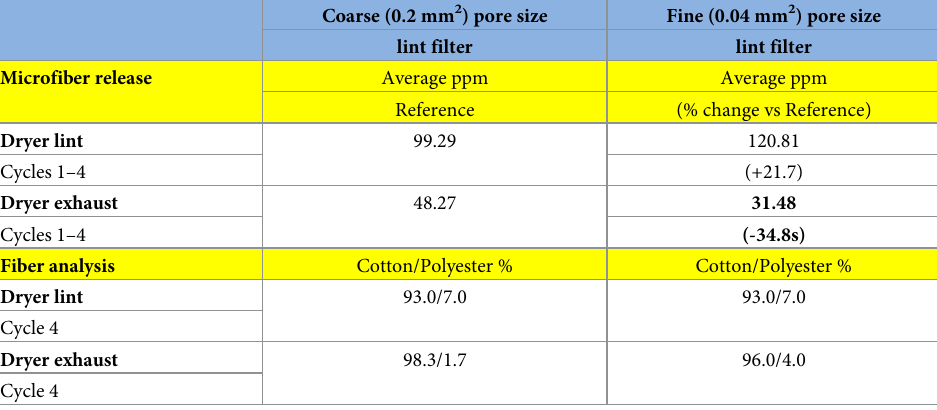
Table 6. Summary of microfiber release and fiber analysis data–impact of lint filter pore size.